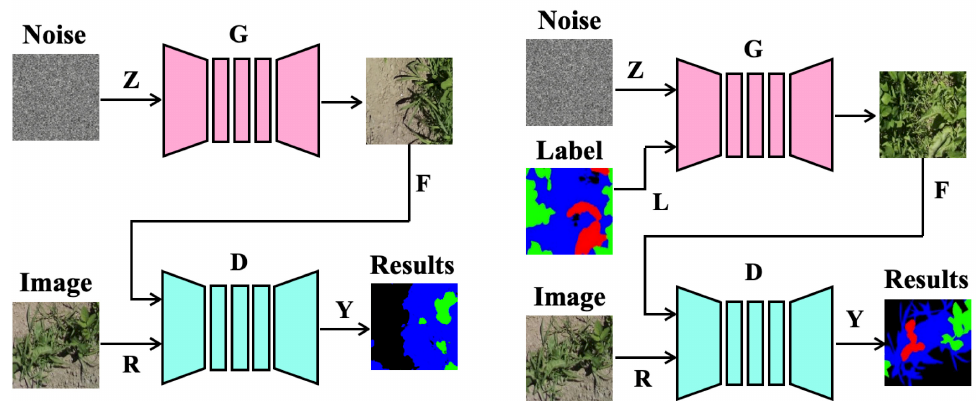
Figure 2. Structural differences between conditional GAN and unconditional